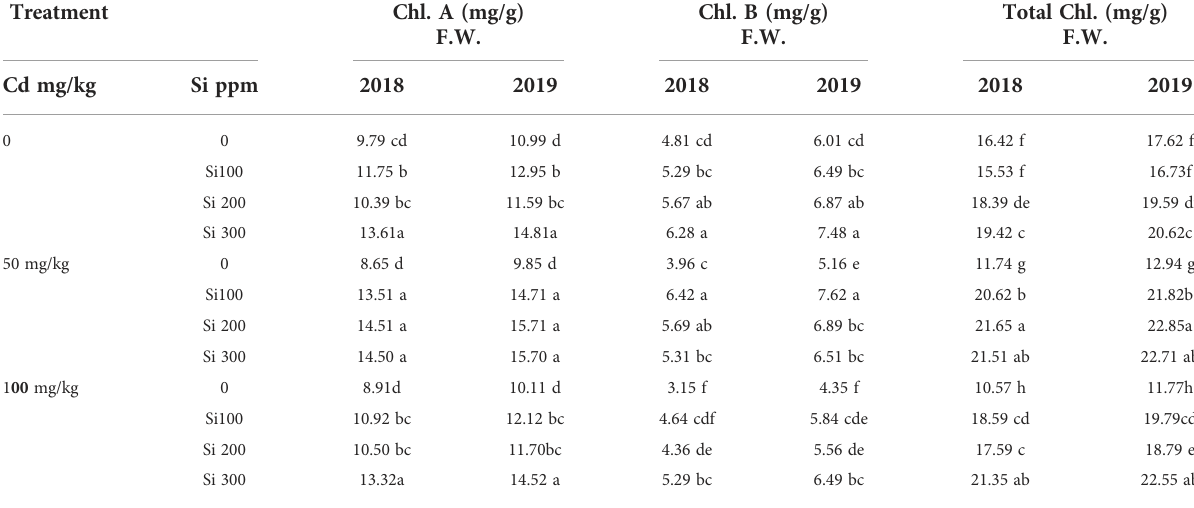
TABLE 4 Effect of foliar application of silicon on pea (chlorophyll pigments) grown in different concentrations of cadmium (Cd) during 2018/2019 and 2019/2020 growing seasons.